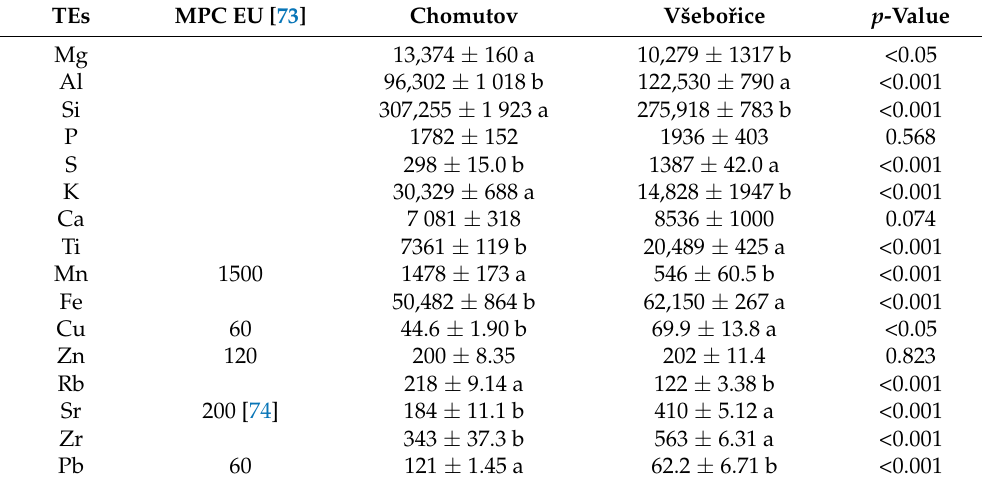
Table 2. TEs’ concentrations (mg kg − 1 ) in the soils from Chomutov and Všeboˇrice; depth of soil sampling: 0–30 cm. Different letters indicate a significant difference between the values within one TE ( p <